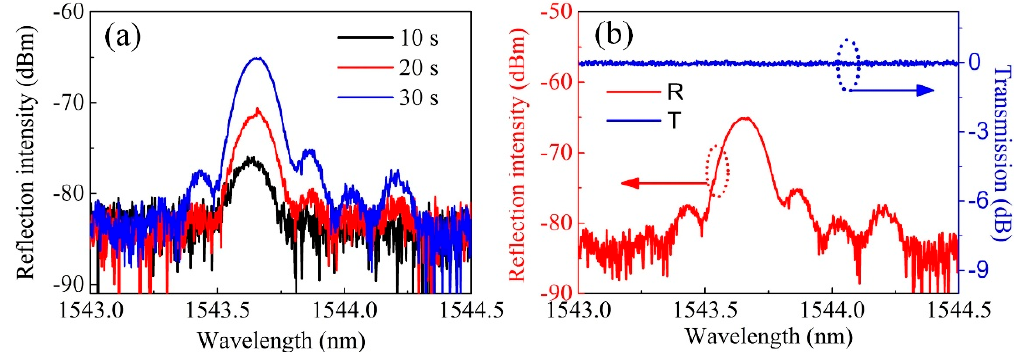
Figure 2. ( a ) Reflection spectrum evolution and ( b ) the ultimate reflection and transmission spectra of the FBG inscribed in a H 2 -free single-mode fiber (SMF).